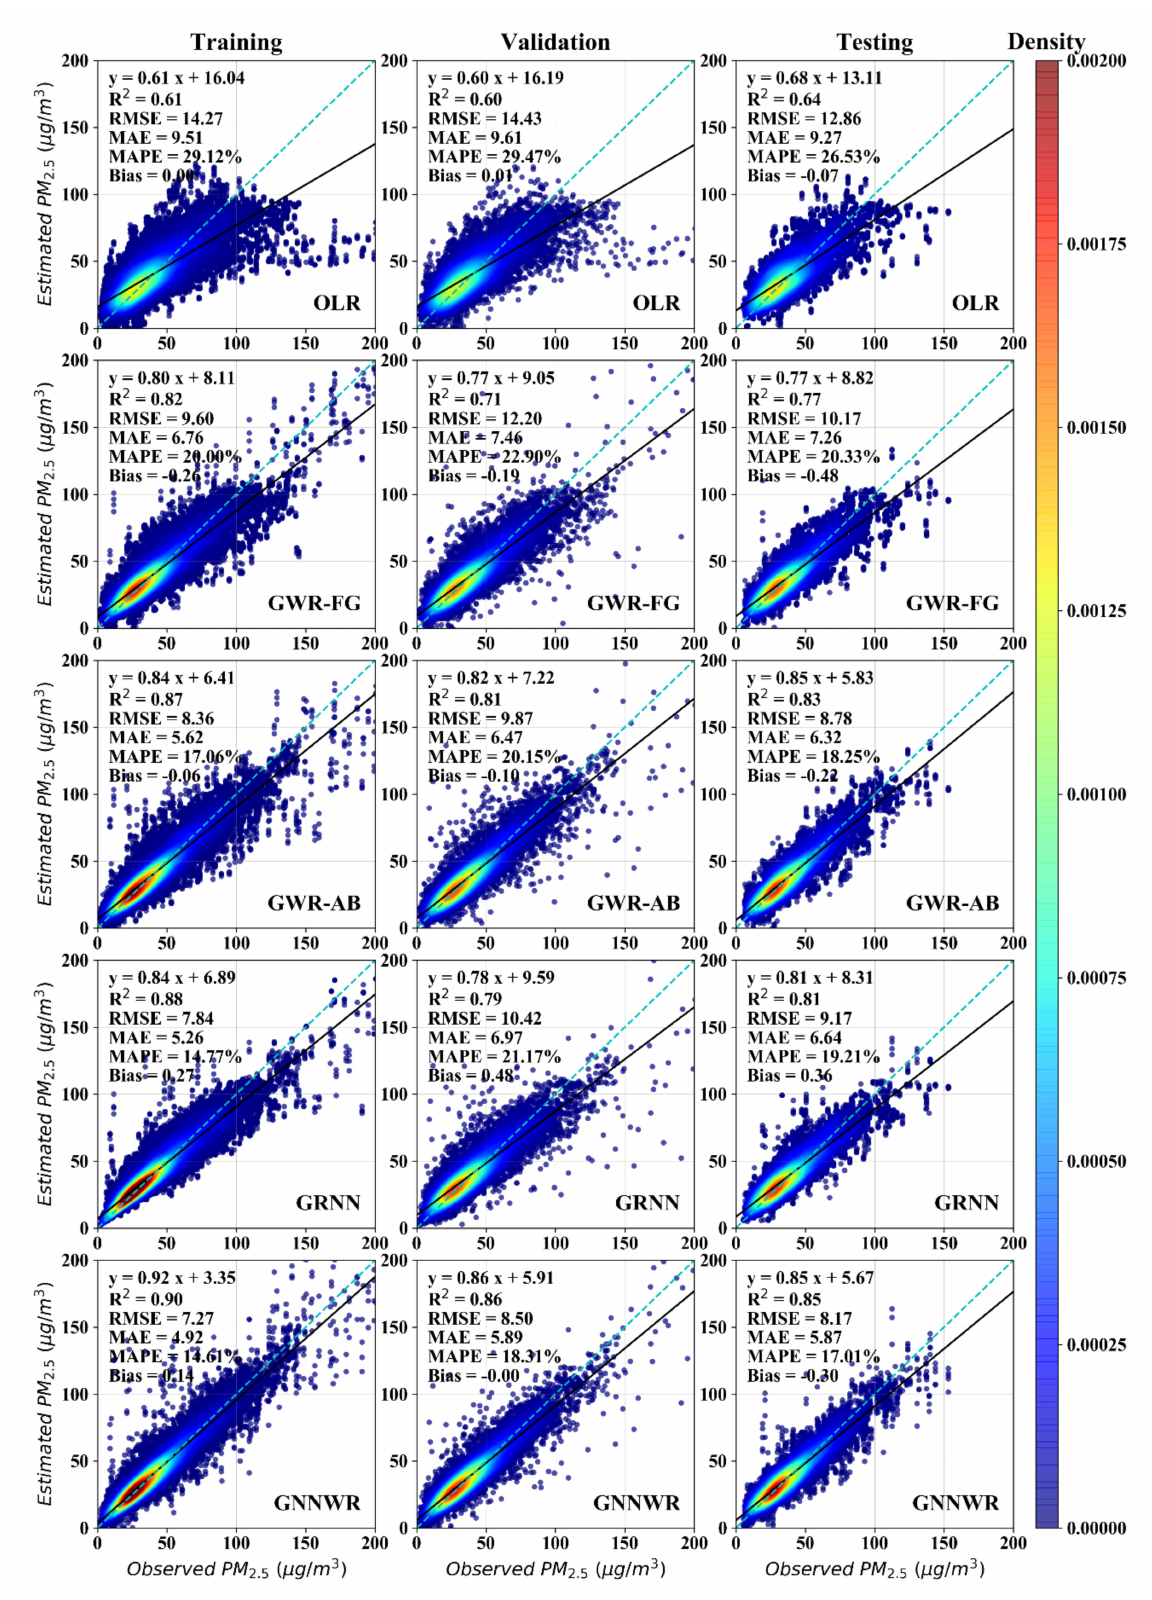
Figure 4. Scatter plots of the PM 2.5 estimates versus the observations of different models: plots in the first, second and third columns are the fitting, validation and testing results,